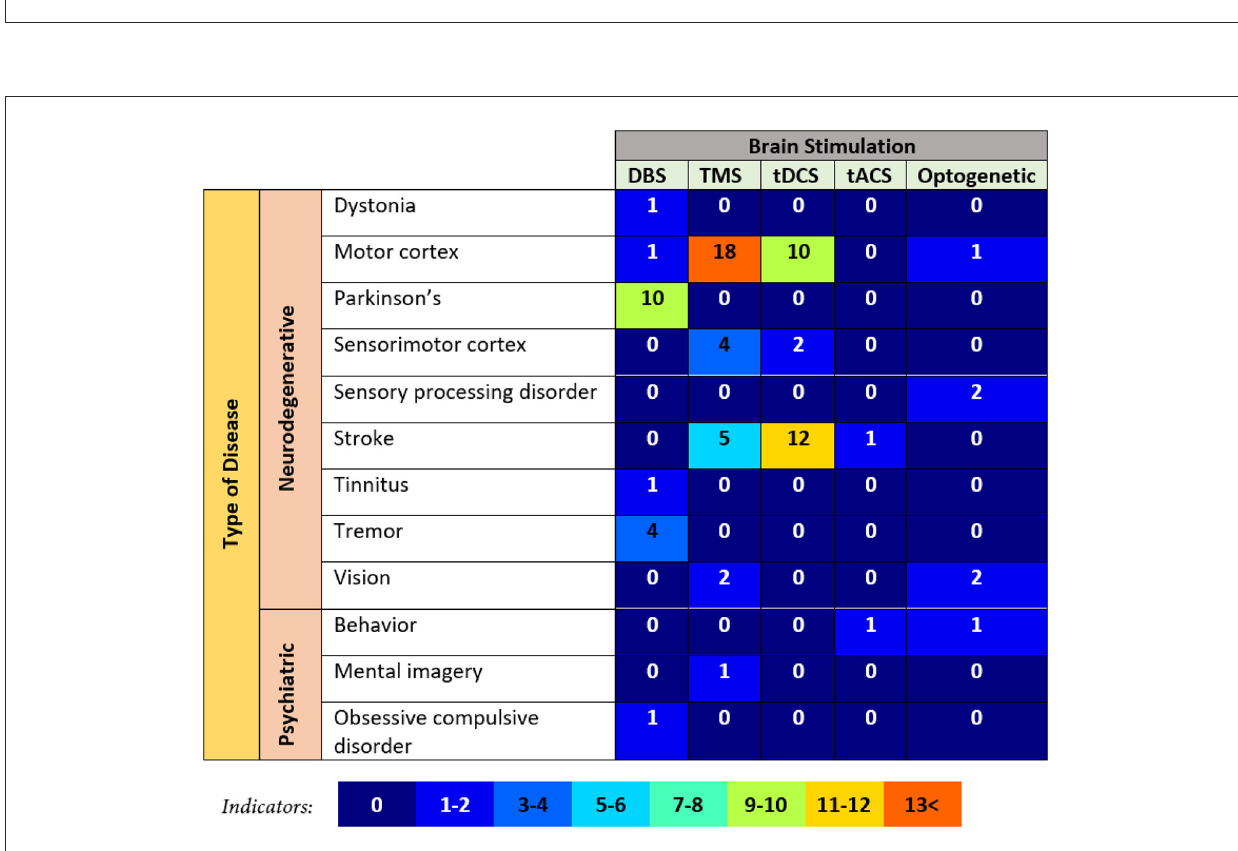
FIGURE5 Publication trend based on brain stimulation. DBS, deep brain stimulation; TMS, transcranial magnetic stimulation; tDCS, transcranial direct current stimulation; tACS, transcranial alternating current stimulation.